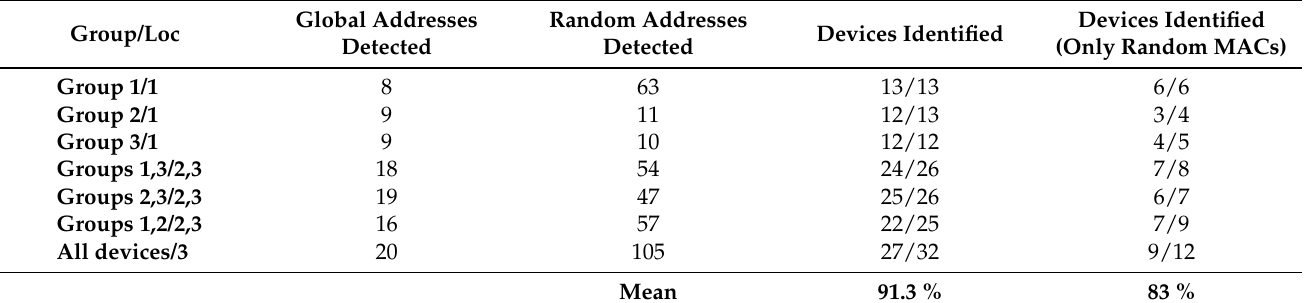
Table 7. MAC de-randomization results for groups of devices for the indoor environment.